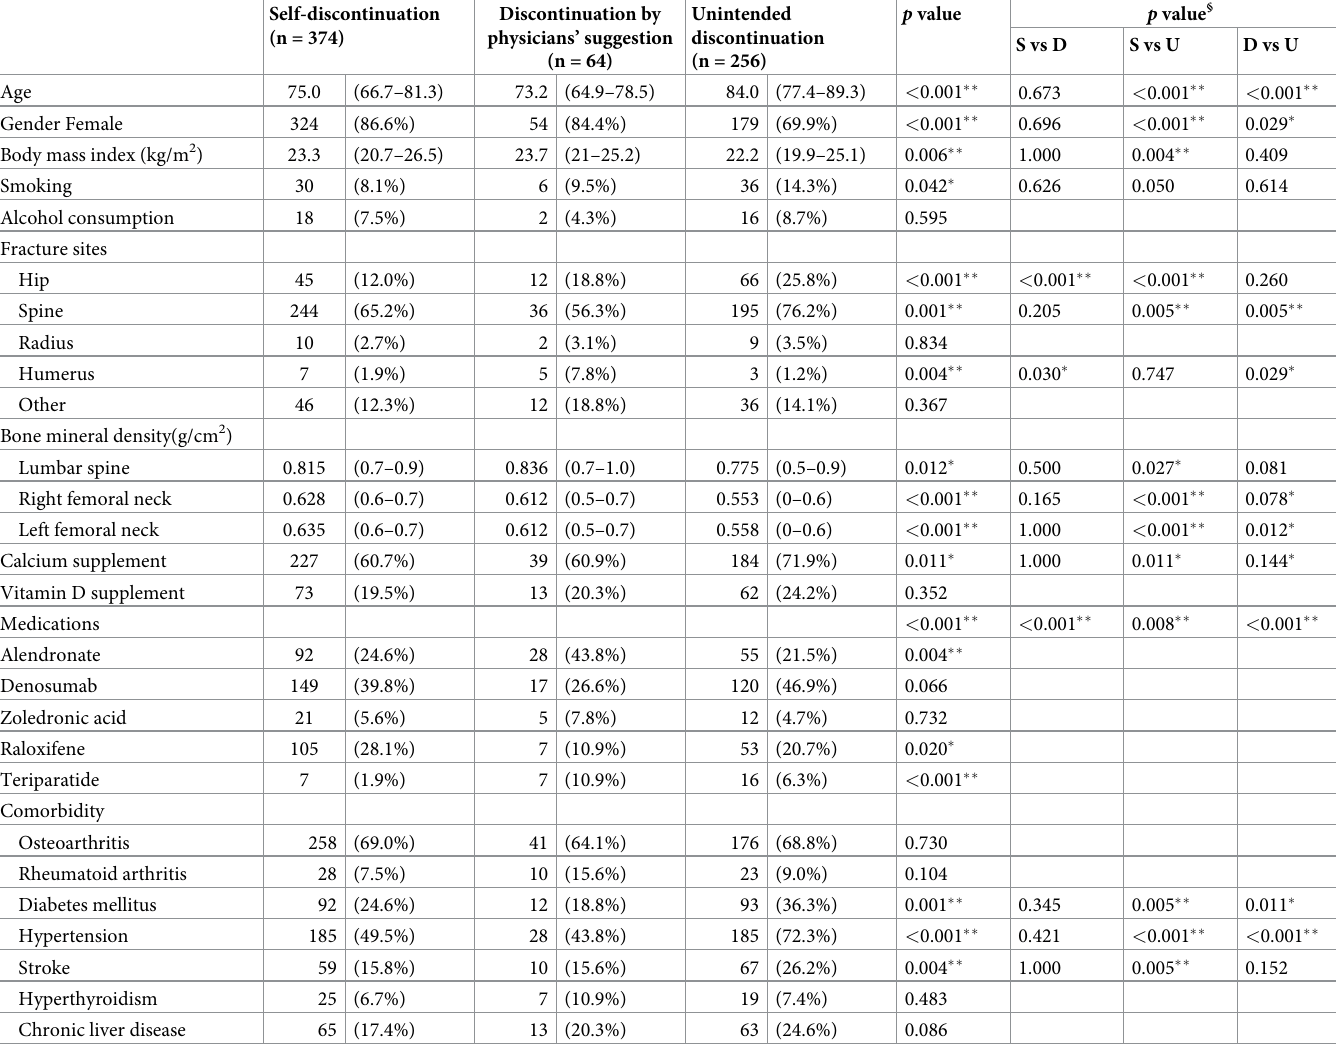
Table 2. Comparisons of demographics among participants discontinued anti-osteoporosis medication due to different